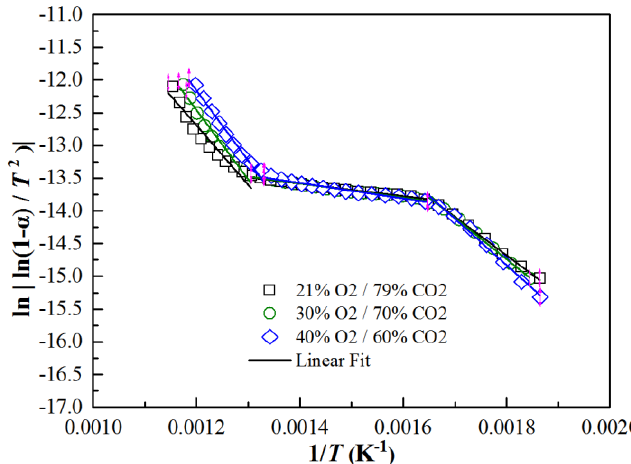
Figure 7. Kinetic analysis curves of 50% SHC + 50% ST under different O 2 concentrations.